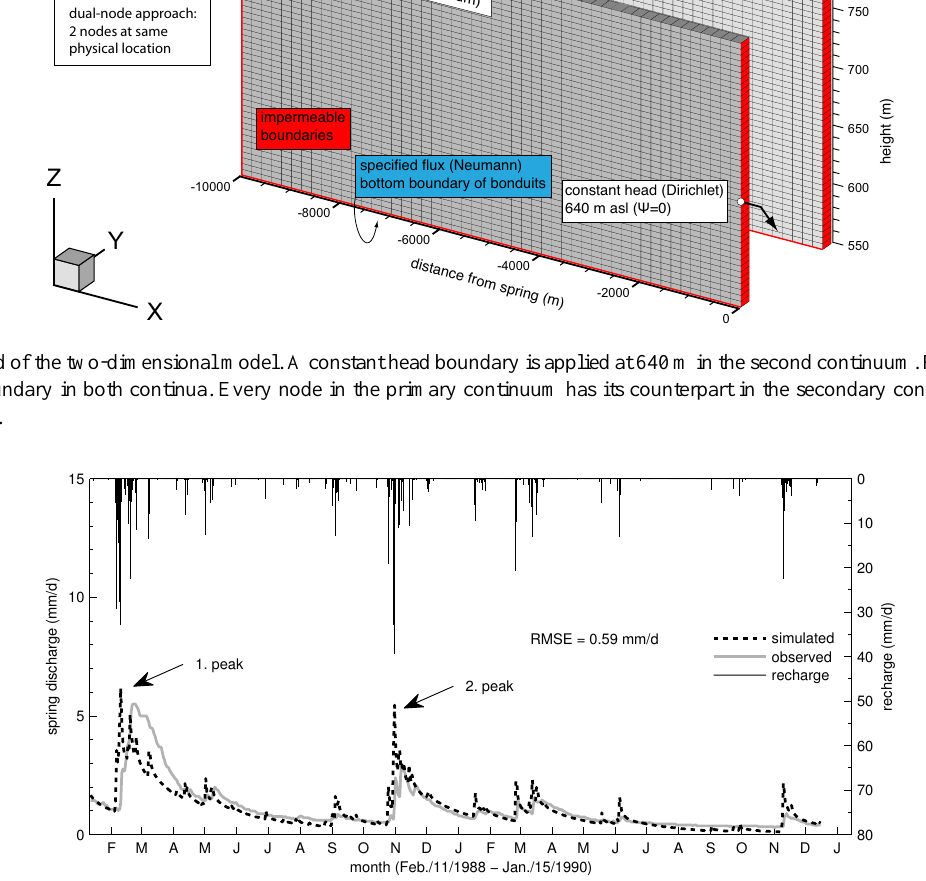
Fig. 4. The calibrated curve shows an acceptable fit. The secondary peak height is overestimated by the model. The first recharge event (first peak) reaches the spring too early. Recession curve slopes show a good overall